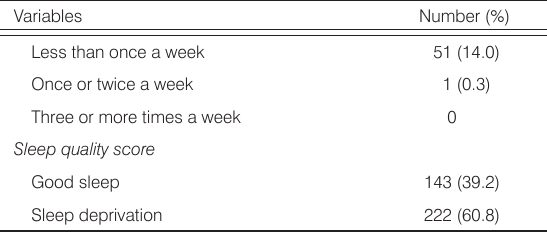
Table 2. Sleep deprivation and its components’ scores among students of the Institute of Health, Jimma University, 2019 ( N =